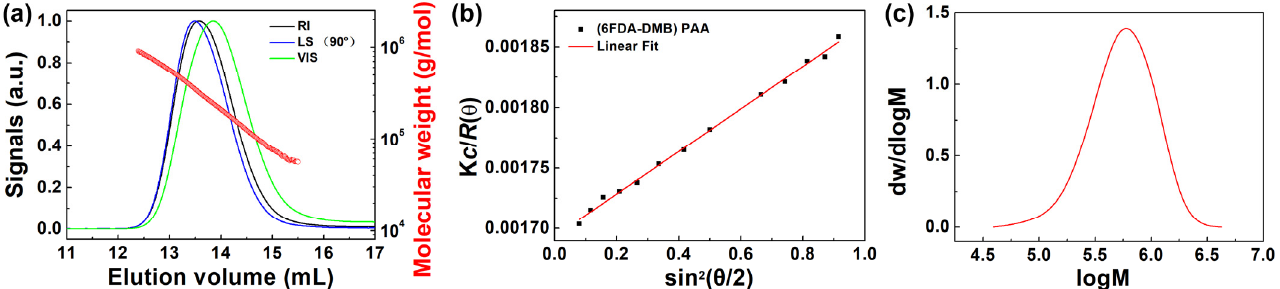
Figure 1. ( a ) RI, LS (90°), VIS signals, and logarithm of molecular weight as a function of elution volume. ( b ) Kc / R ( θ ) vs. sin 2 ( θ /2) plot. ( c ) Molecular weight distribution curve for original (6FDA- DMB) PAA.